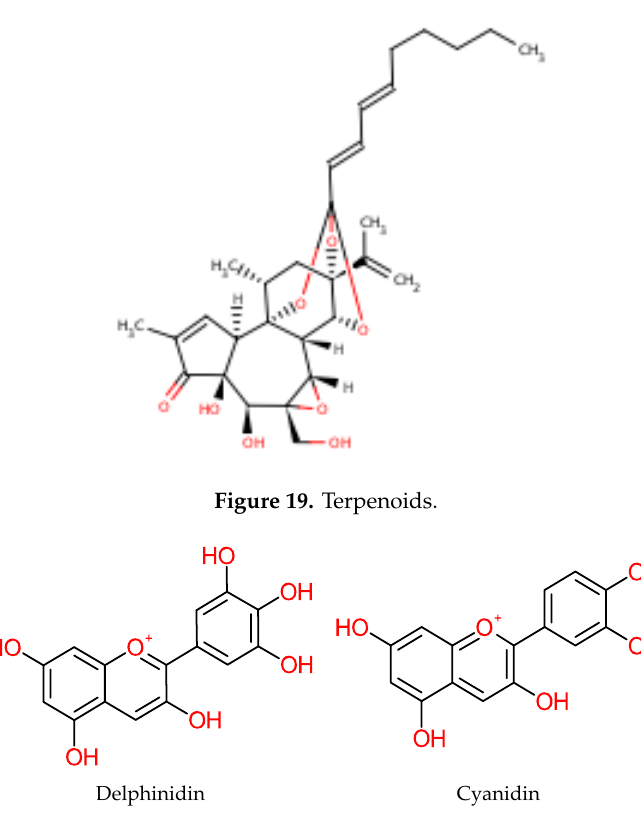
Figure 20. Structure of Anthocyanins.